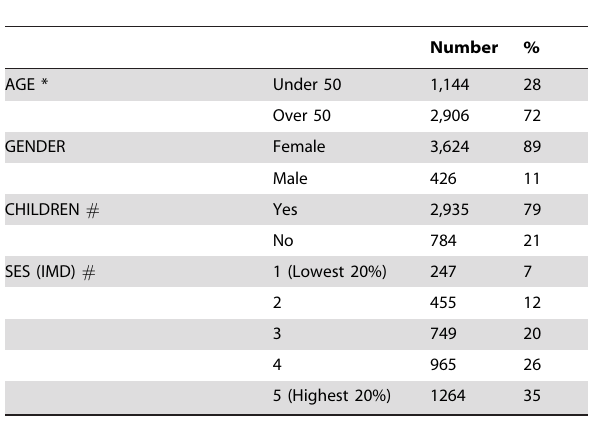
Table 1. Respondents